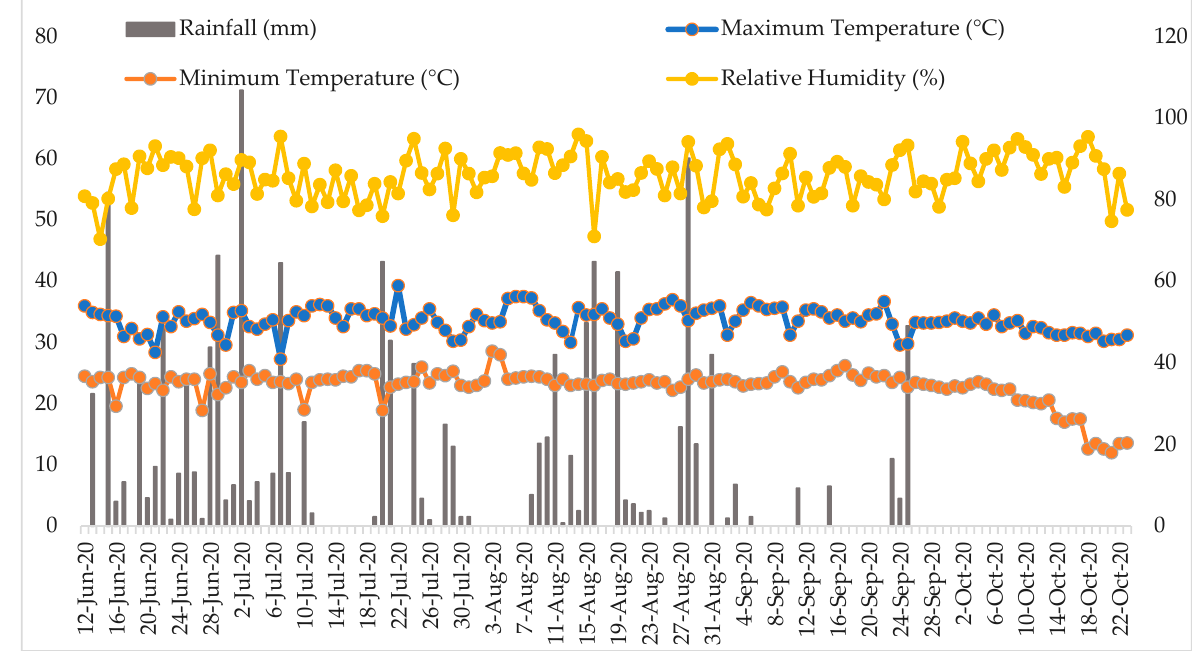
Figure 1. Daily fluctuations of maximum and minimum temperature, humidity, and rainfall recorded during the study period. Data of rainfall and temperatures are represented in the primary vertical axis and humidity in the secondary vertical axis. Dates are presented in day-month-year format, year is 2020 (Data source; Office of Hydrology and Meteorology, Kohalpur- we used data of nearest sub- station Mehelkuna).